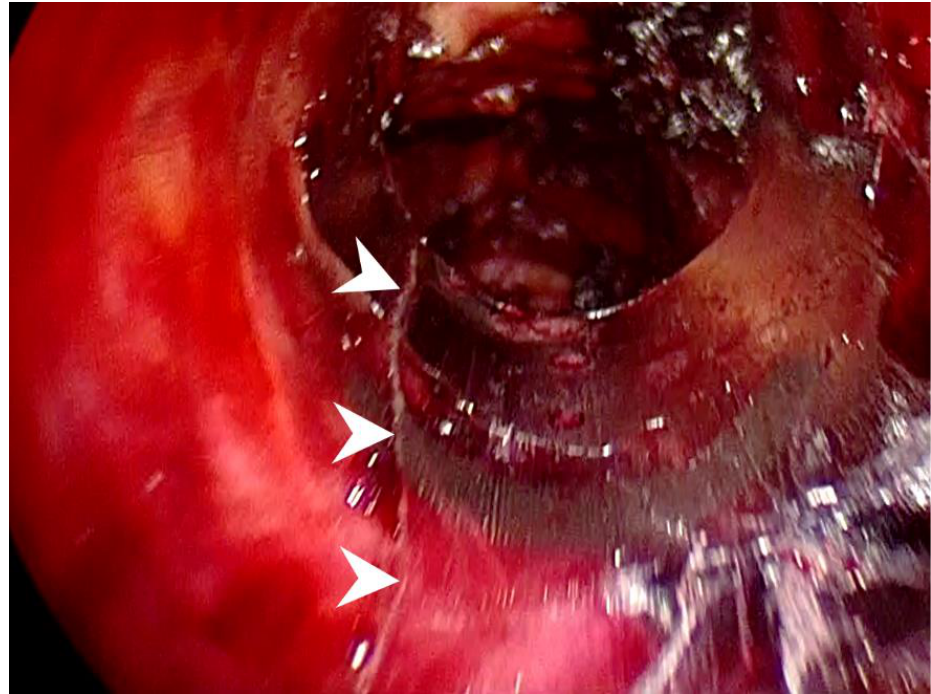
Figure 1. Intraoperative view of Case 1 demonstrating a linear fracture on the left ventral side of the cannula ( arrowheads ).